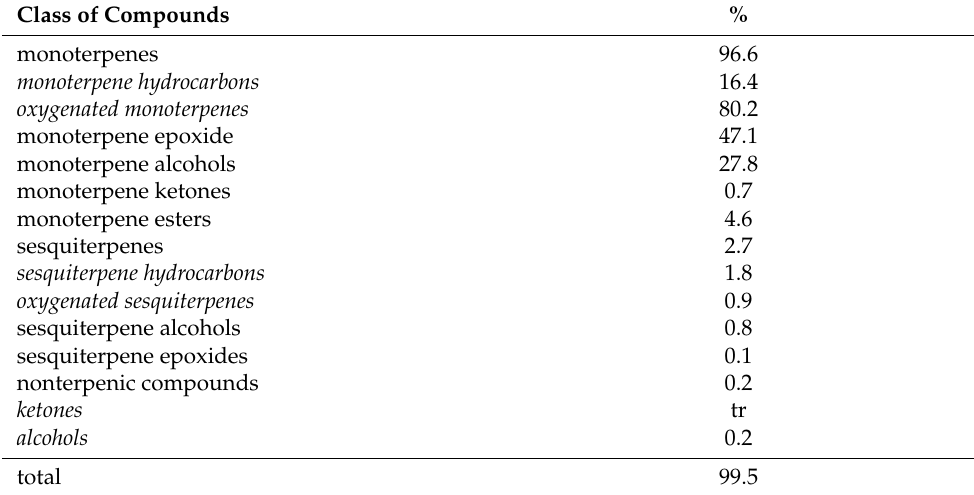
Table 2. The total amounts of volatiles, presented in percentages for each class of compounds. Class of Compounds